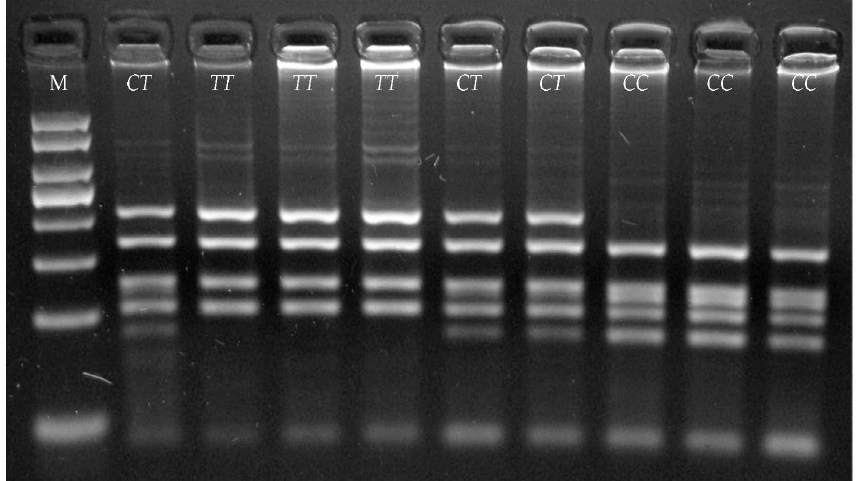
Figure 2. Determination of THRSP genotypes by use of PCR-RFLP method, M—50 bp DNA Ladder (50, 100, 150, 200, 250, 300, 400, 500 bp) (Genoplast, Poland).